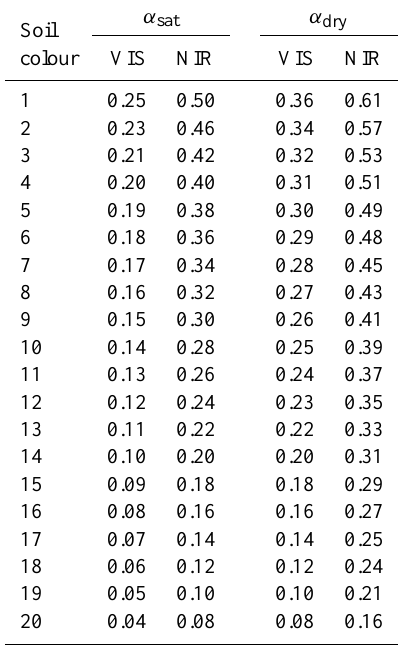
Table 5. Saturated- and dry-soil albedos for 20-class soil colours (Fig. 11) in the VIS and NIR